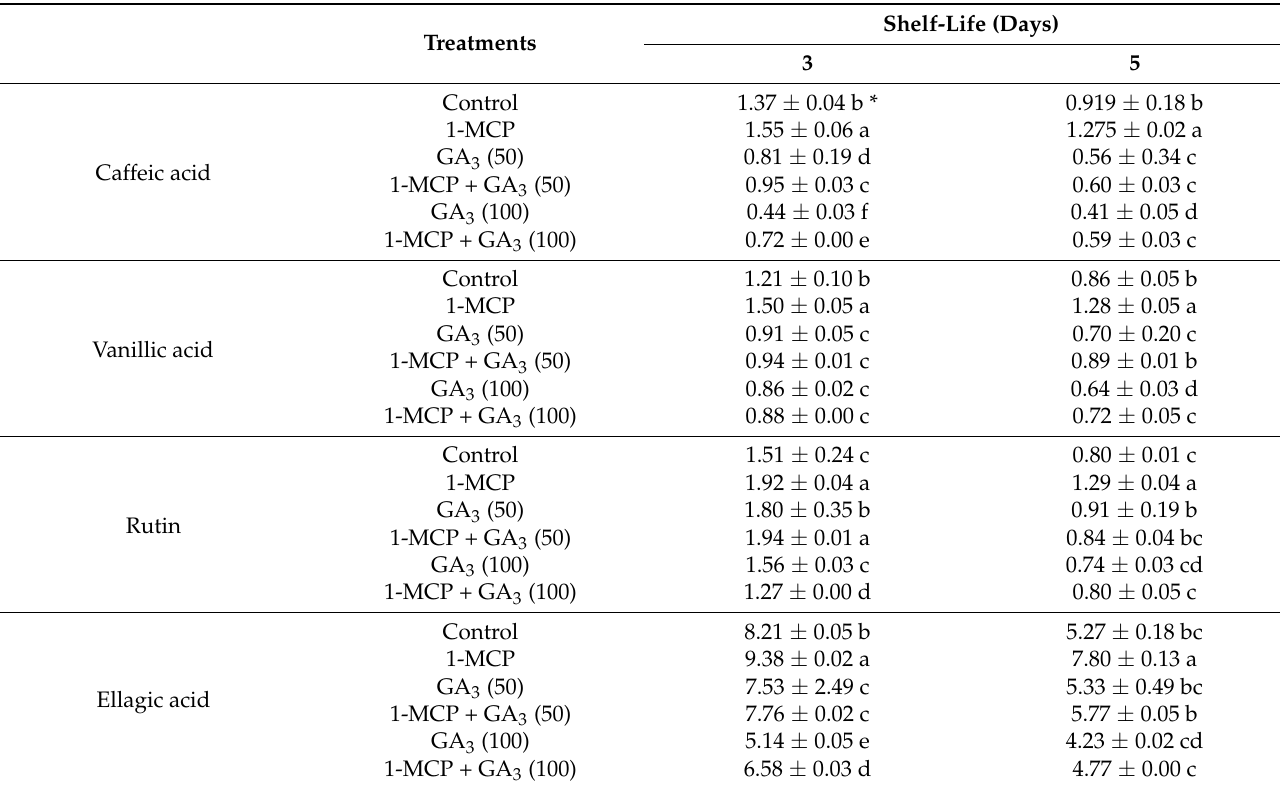
Table 4. Effect of 1-MCP and GA 3 treatments on the caffeic, vanillic, rutin, and ellagic acid contents during shelf-life of strawberry fruits (mg 100 g − 1 ).